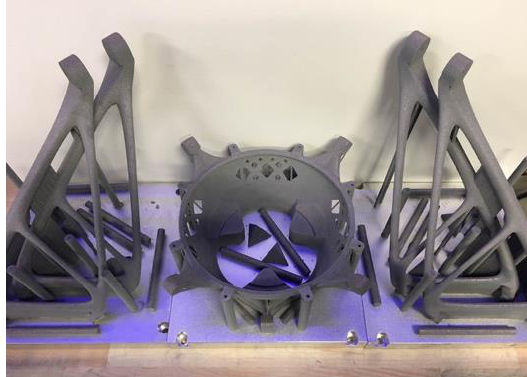
Figure 21. Photograph of three build plates after additive manufacturing.